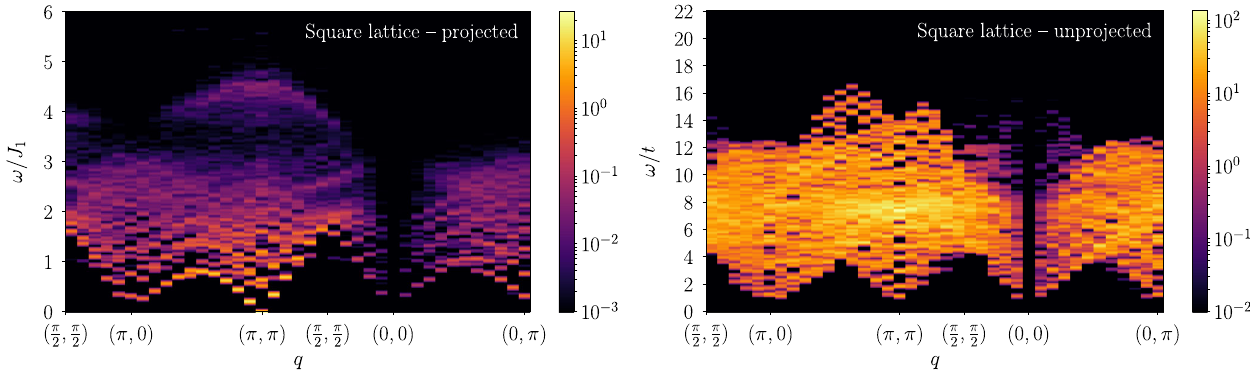
FIG. 9. The dynamical structure factor for the J 1 − J 2 Heisenberg model on the square lattice ( 22 × 22 ) with J 2 =J 1 ¼ 0 . 55 . The variational results (left) are compared to the ones obtained from the unprojected Abrikosov fermion Hamiltonian H 0 (right), which contains a flux-phase hopping (of strength t ) and a d xy pairing (see Ref. [46] for details). We applied a Gaussian broadening of σ ¼ 0 . 02 J 1 to the variational results. Notice that, for the unprojected data, the energy scale is given by the hopping amplitude unprojected Hamiltonian of Ref. [46], instead of J 1 . In addition, the broadening has been rescaled in order to account for the larger bandwidth of the